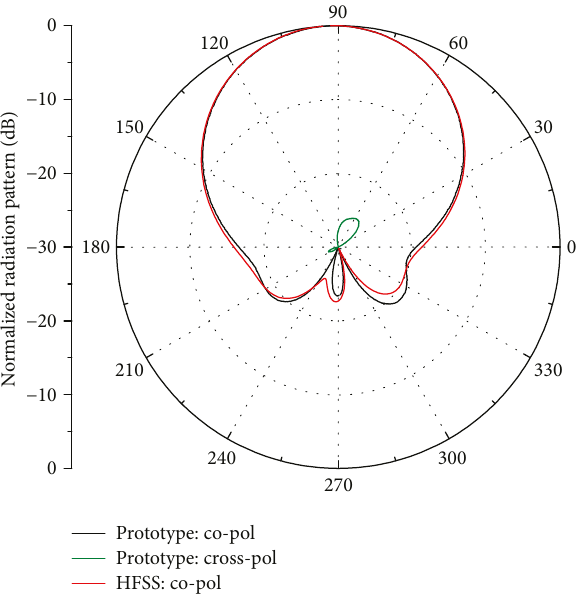
Figure 27: Normalized E plane radiation pattern.